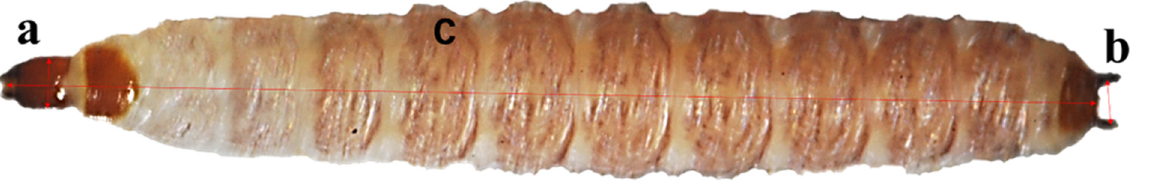
Figure 1. A schematic diagram of Necrobia ruficollis larval measurement. The two-way arrow high- lights the indicators measured in this study, wherein ( a ) represents head capsule width, ( b ) represents distance between urogomphi, and ( c ) represents larval body length.